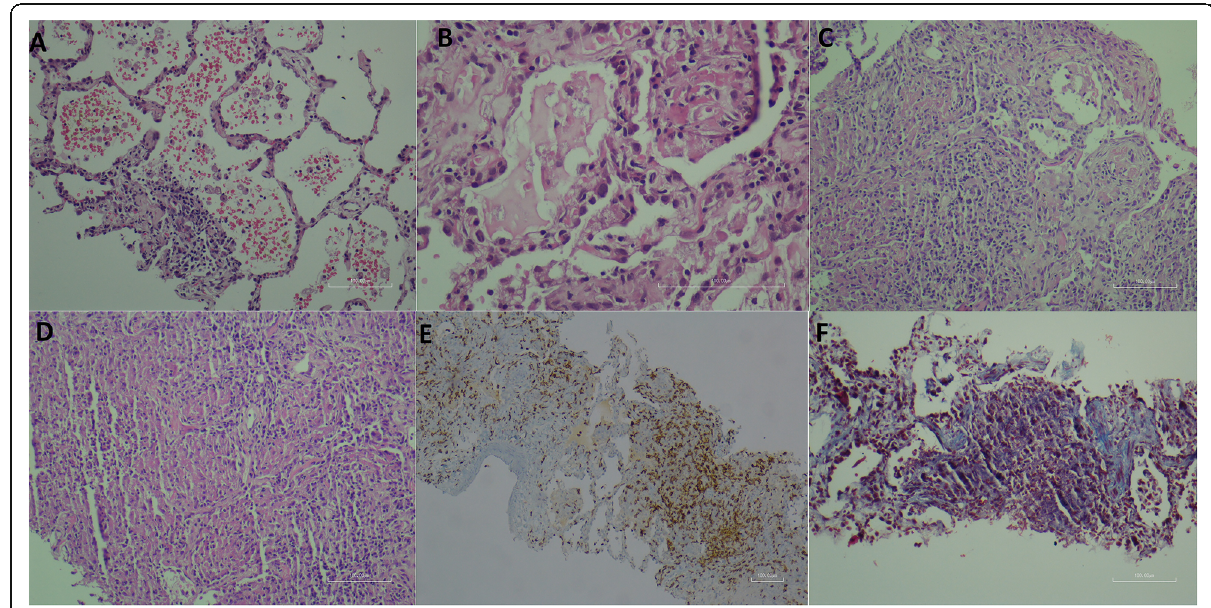
Fig. 2 Histopathological changes in the lung in COVID-19 pneumonia; a Alveolar damage, congestion, inflammation (HE × 100); b pneumocyte hyperplasia, interstitial fibrosis (HE × 400), c early fibrotic changes, fibrinous, organized pneumonia (HE × 100), d noncaseating suppurative granulomatous inflammation with neutrophils (HE × 100), e inflammation consisted rich in CD3 positive lymphocytes (HE × 40), f interstitial fibrosis was confirmed with Masson Trichrome histochemical stain (HE ×